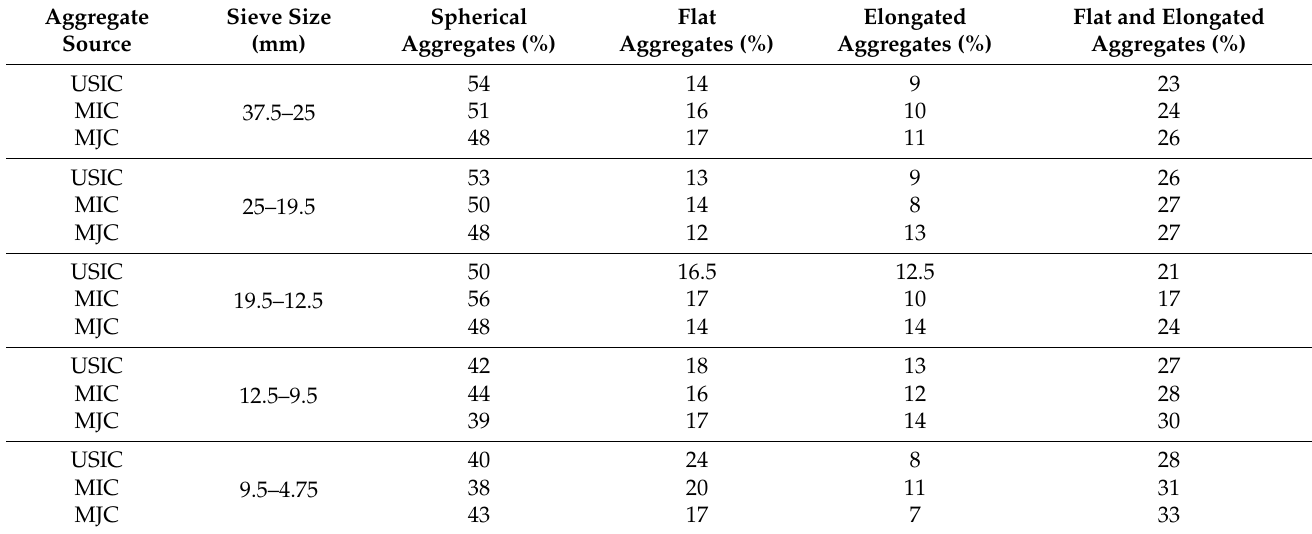
Table 2. Proportion of aggregates from different